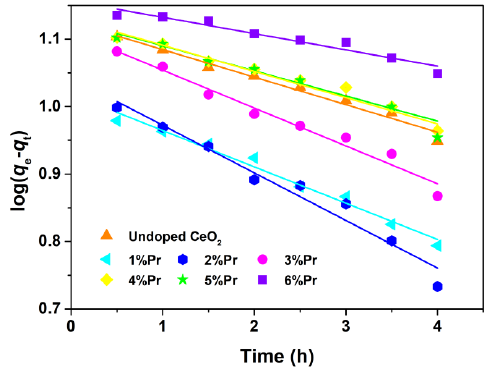
Figure 9. Kinetic fitting for the degradation of AO7 dye with Undoped CeO 2 and Pr−doped CeO 2 under ultraviolet lamp (300 W; λ = 254 nm). Table 2. Kinetic parameters for the degradation of AO7 dye onto Undoped CeO 2 and Pr−doped CeO 2 under ultraviolet lamp.